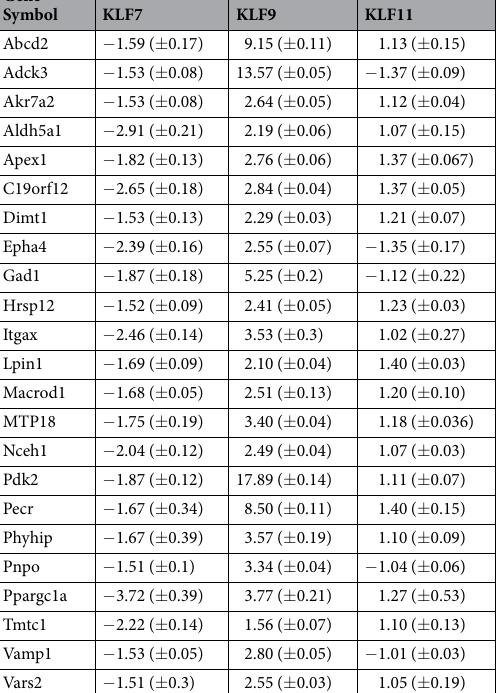
Table 1. Mitochondrial-associated gene candidates that are also associated with axon growth regulation. Fold change presented relative to mCherry controls. Data represented as mean expression ± SEM values (N = 5 or more independently repeated